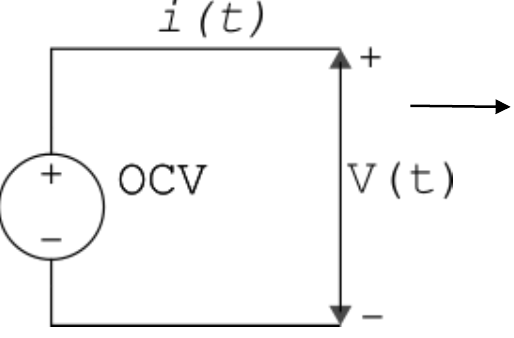
Figure 2. Poor Voltage Method.